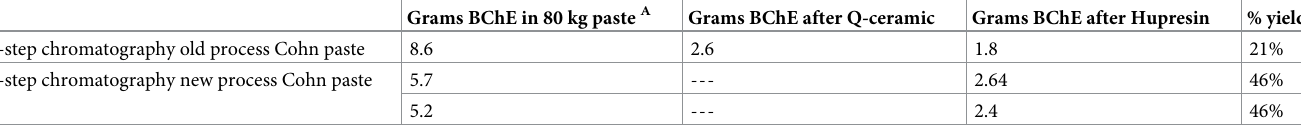
Table 3. Yield of highly purified human BChE from 2-step chromatography and 1-step